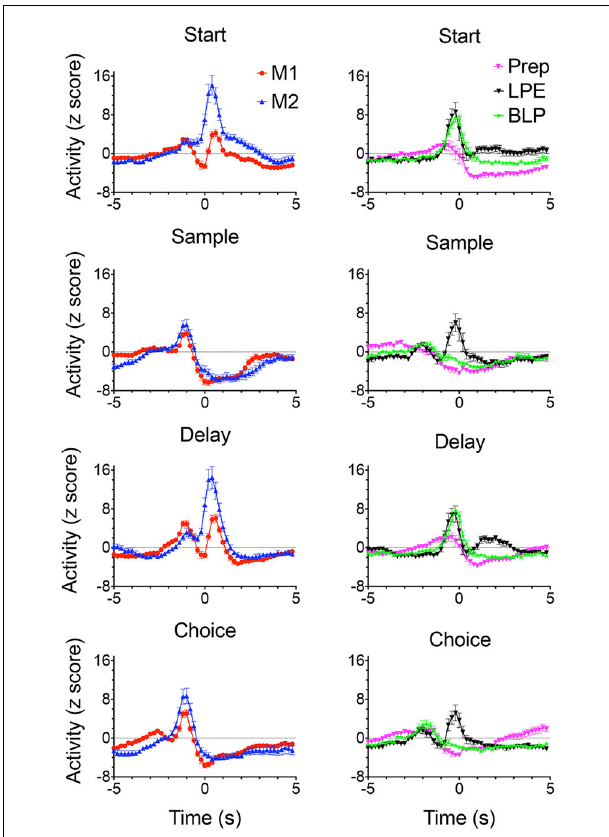
FIGURE 7 | Normalized population PETHs based on all examples observed of action-related responses. Movement 1 (M1) fired during movements toward each lever in the sequence ( N = 97). Movement 2 (M2) fired during movements toward the sample and choice levers and were directionally specific ( N = 32). Lever press excitation (LPE) fired during each of the 4 lever presses in the sequence ( N = 28). Base lever press (BLP) fired during start and delay lever presses ( N = 30). Preparatory (Prep) exhibited activity that ramped up to a peak just before the start and (to a lesser extent) the delayed responses ( N = 44). Activity is aligned with each of the lever presses and plotted for 5 s before until 5 s after the aligned event. Error bars represent the standard error of the mean. Data are replotted from Francoeur and Mair (2018).